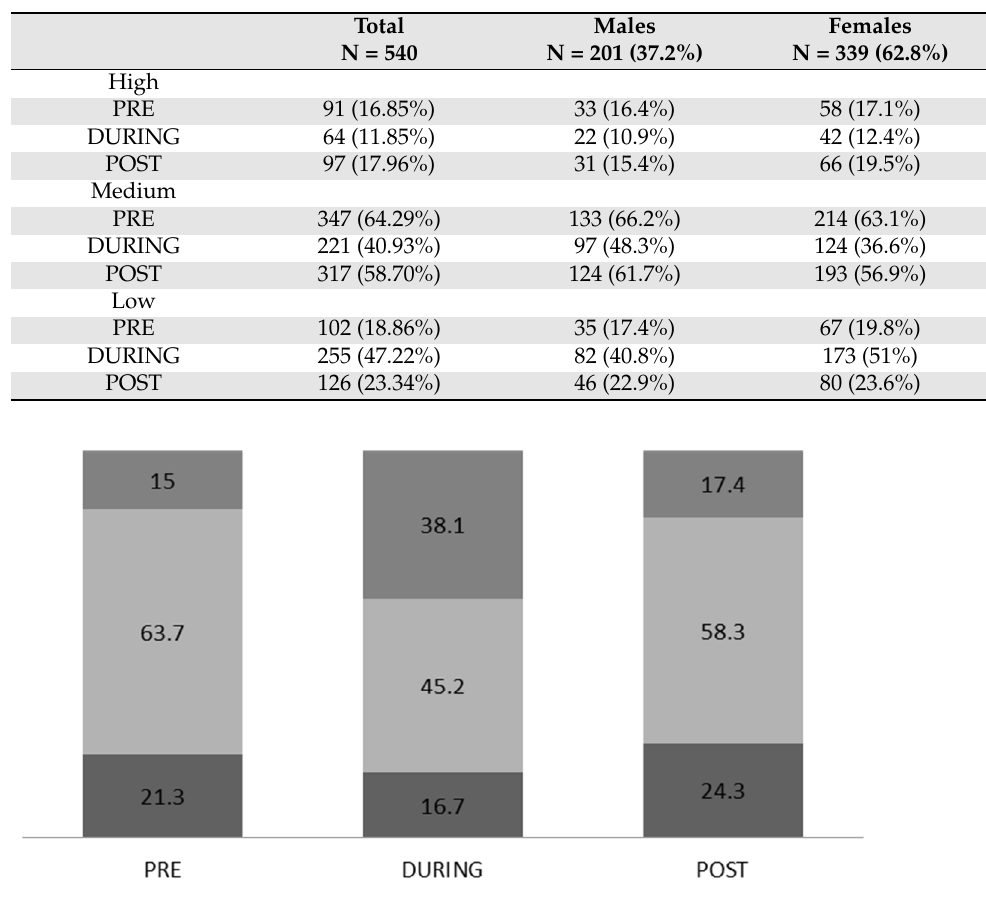
Figure 6. Frequency of alcohol consumption.